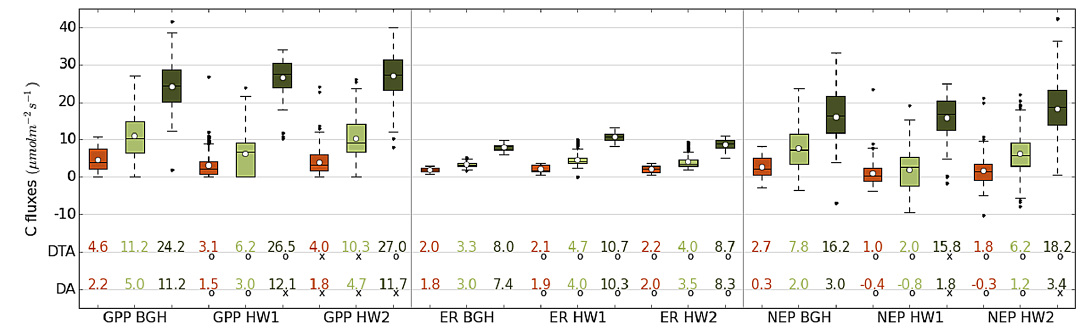
Figure 8. Boxplot of daytime values (09:00–16:00 local standard time) of gross primary productivity (GPP), ecosystem respiration (ER) and net ecosystem productivity (NEP) for the background period (BGH) and the first and second period of the heat wave (HW1, HW2). Daytime average values (DTA) are given below boxes and symbols indicate that they are significantly different from the background period (o) or not (x). Daily averages (DA, 00:00–23:00, local standard time) and their significance are also given. Colours as in Fig.